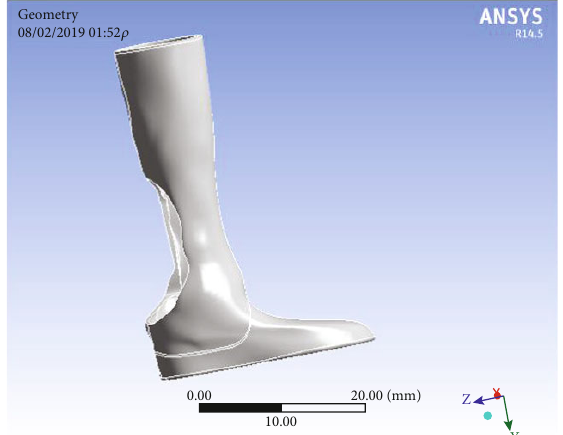
Figure 7: Prosthetic model